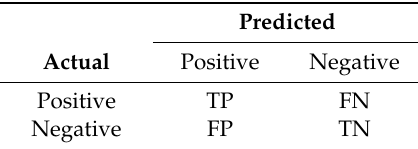
Table 2. Confusion matrix